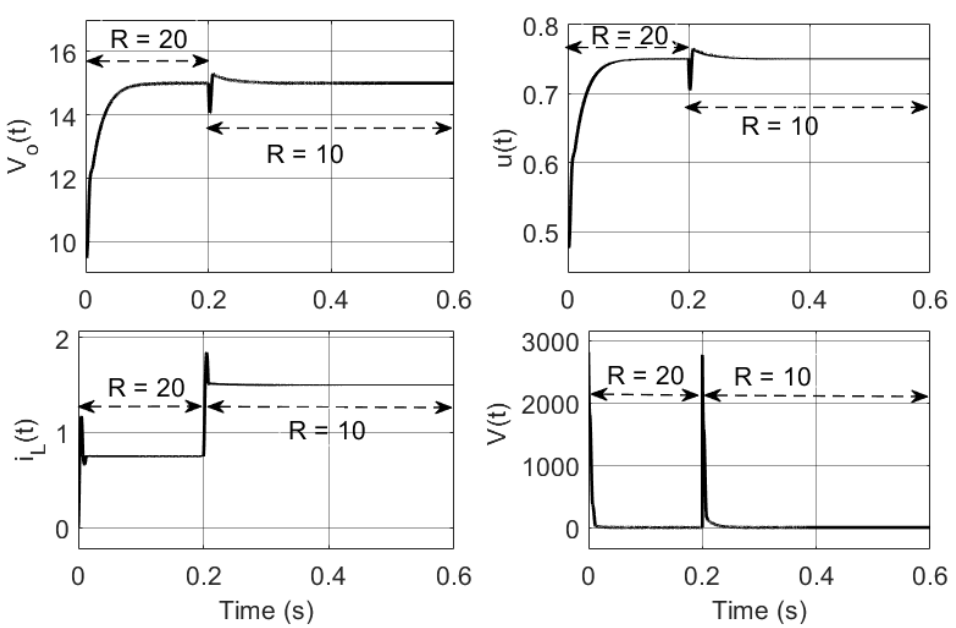
Figure 2. Time trajectories of the output voltage v o ( t ) , inductor current i L ( t ) , control signal u ( t ) , and the Lyapunov function (Load variation).